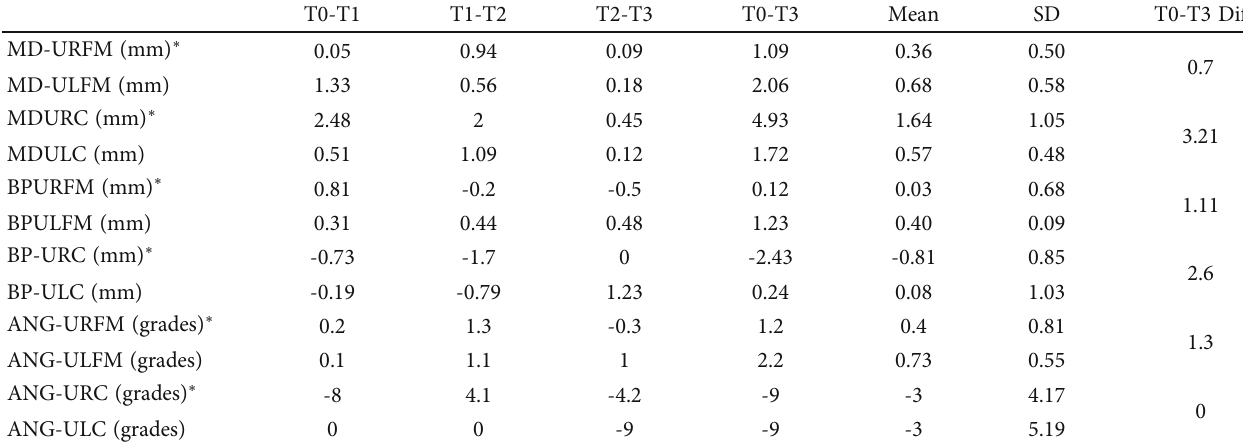
Table 1: Changes in linear and angular movement of fi rst molars and canines at di ff erent time